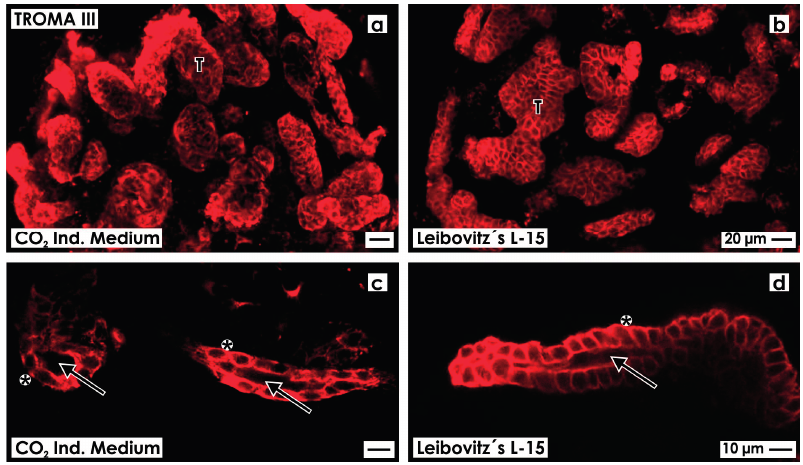
Figure 1. Confocal fluorescence microscopy of anti-TROMA III labeled renal tubules generated in an artificial interstitium during perfusion culture. Development of numerous tubules (T) can be seen, when CO 2 Independent Medium ( a ) or Leibovitz’s L-15 Medium ( b ) was administered; ( c , d ) Analyzed tubules exhibit a lumen (arrow) and a basal lamina